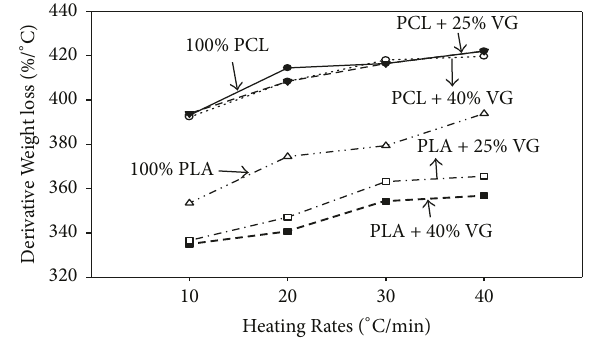
Figure 10: % loss of PCL and PLA vital gluten blends at different heating